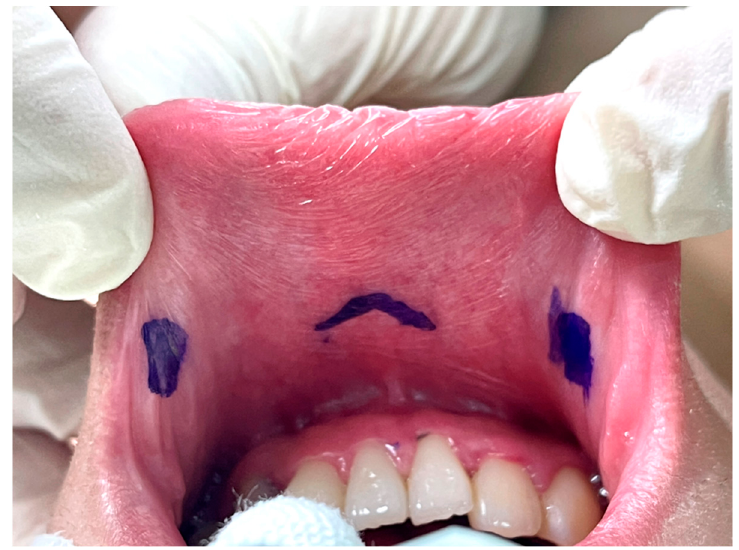
Figure 2. Vestibular incision design in transoral thyroidectomy. The other two lateral incisions (0.5 cm) were made close to the inner edge of the bilateral mouth commissure